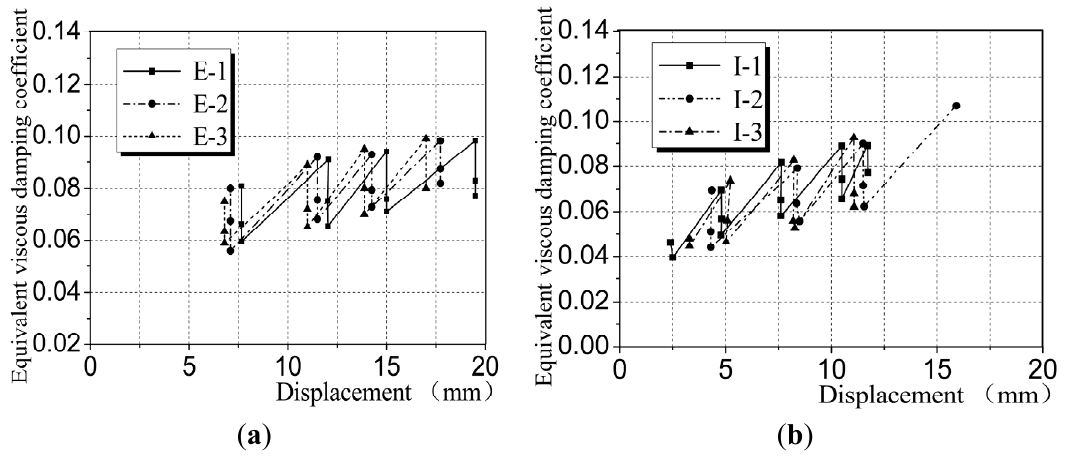
Figure 13. Displacement-equivalent viscous damping coefficient diagram. ( a ) CEW; ( b ) CIW.